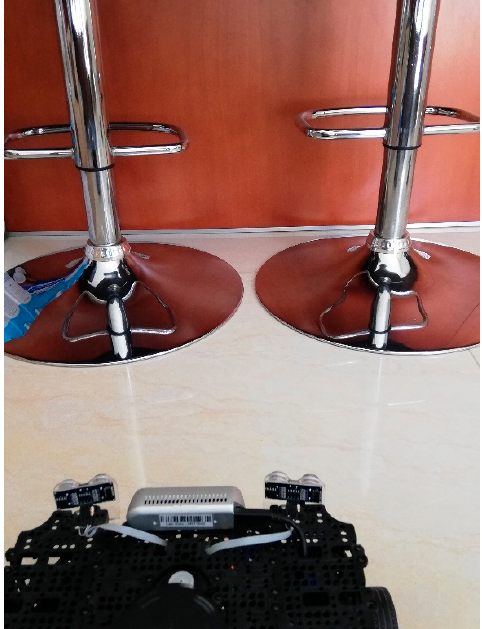
Figure 18. Point of interest of scenario 2.